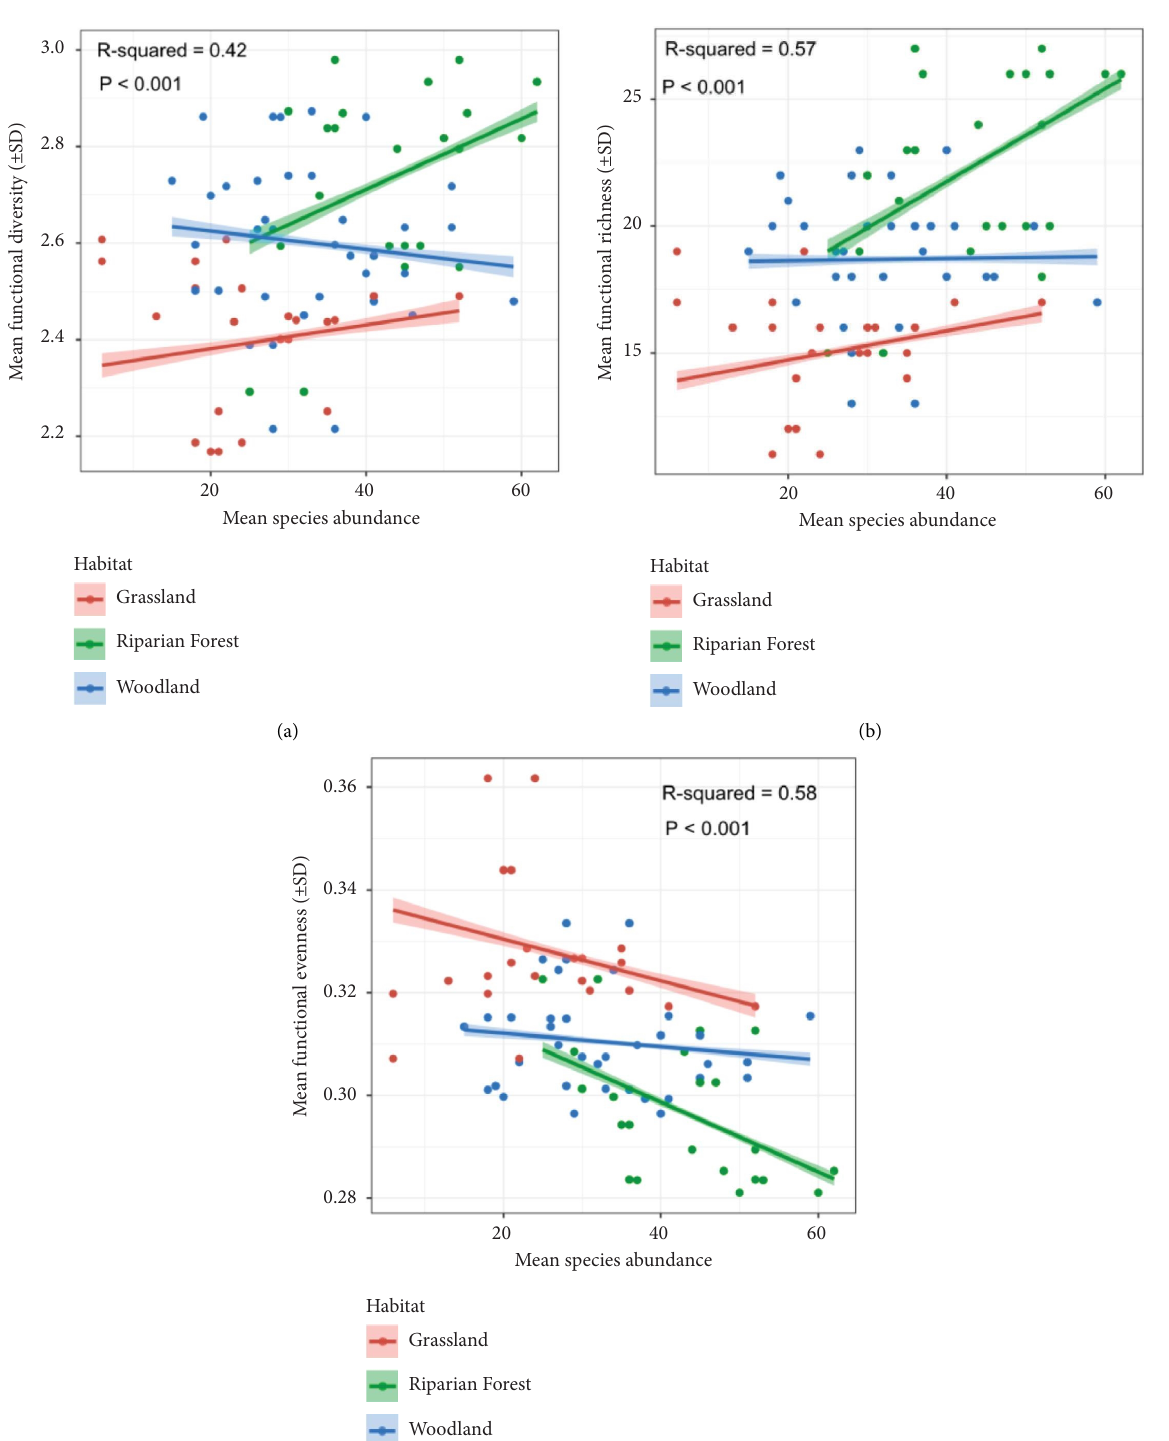
Figure 5: Relationships between overall avifaunal abundance and those of functional diversity measures in the MNP. ((a) mean functional diversity versus mean species abundance, (b) mean functional richness versus mean species abundance, and (c) mean functional evenness versus mean species